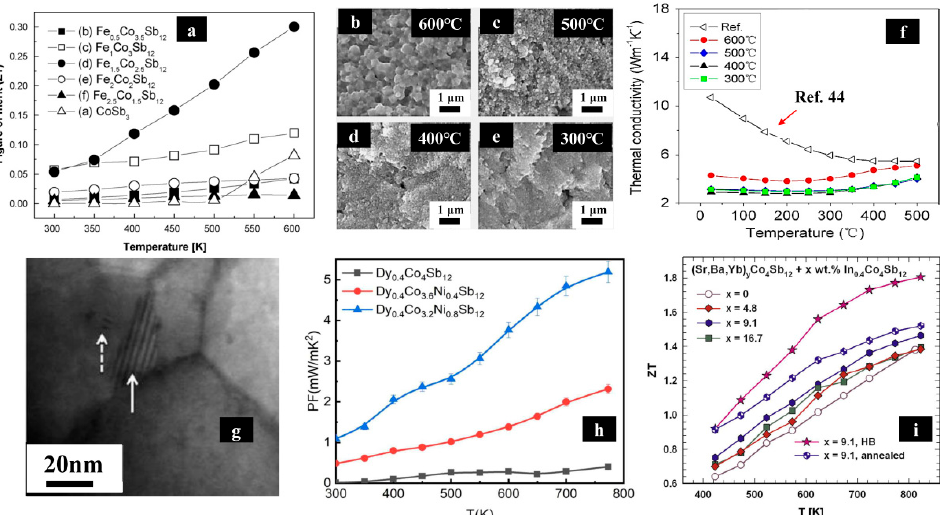
Figure 5. ( a ) Temperature dependence of ZT values and temperature of Fe x Co 4-x Sb 12 (0 ≤ x ≤ 2.5) [42]; ( b – e ) FESEM images of CoSb 3 materials at different sintering temperatures; ( f ) temperature dependence of thermal conductivity for polycrystalline CoSb 3 materials prepared at different sintering temperatures [43]; ( g ) HRTEM image of Dy 0.4 Co 3.2 Ni 0.8 Sb 12 (dotted arrow points to the defect in the particle and solid arrow points to the Moire fringe); ( h ) temperature dependent of power factor for Ni doped Dy filled CoSb 3 samples [45]; ( i ) temperature dependence of ZT values for (Sr, Ba, Yb, In) y Co 4 Sb 12 [46].